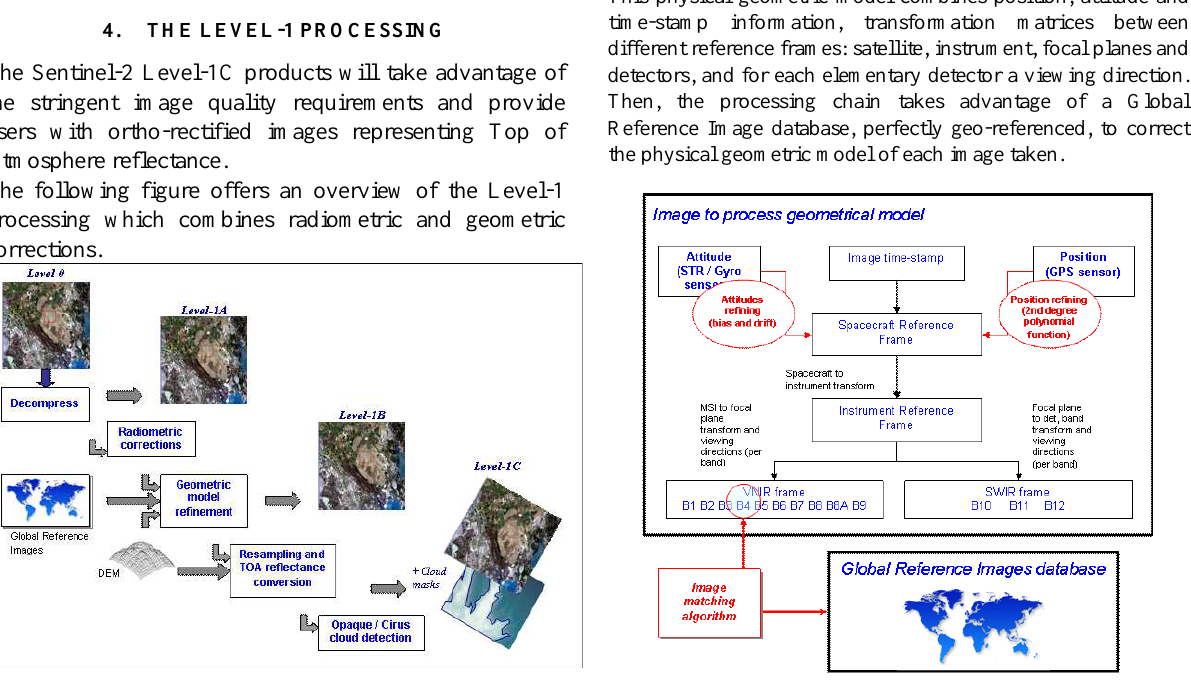
Figure 5: Sentinel-2 physical geometric model refinement based on automatic correlation with reference